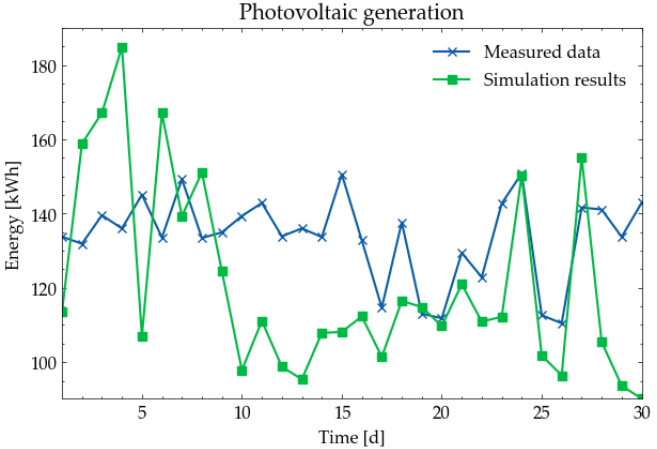
Figure 14. Electrical grid validation. Simulation results against PV generation measurements.